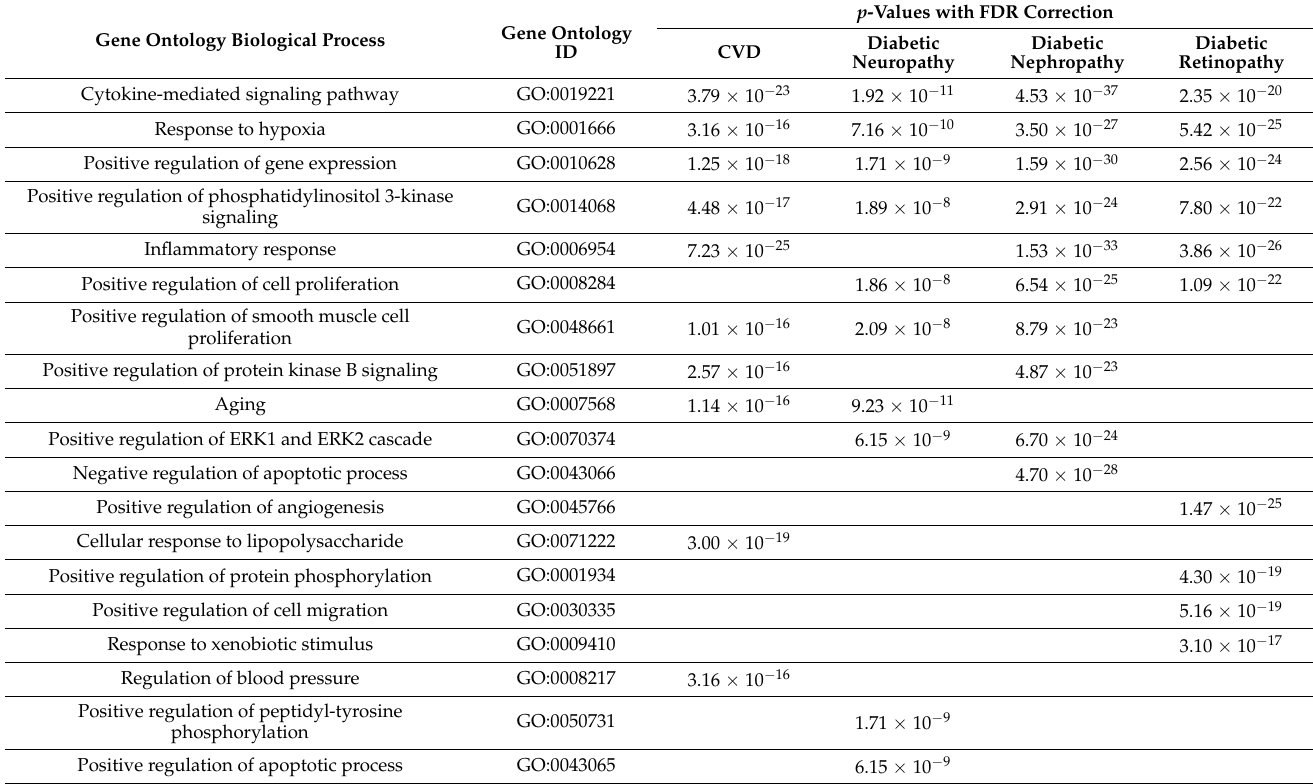
Table 11. Most overrepresented GO biological processes for the sets of genes linked with SARS-CoV- 2-targeted human proteins and associated with CVD, diabetic neuropathy, diabetic nephropathy, and diabetic